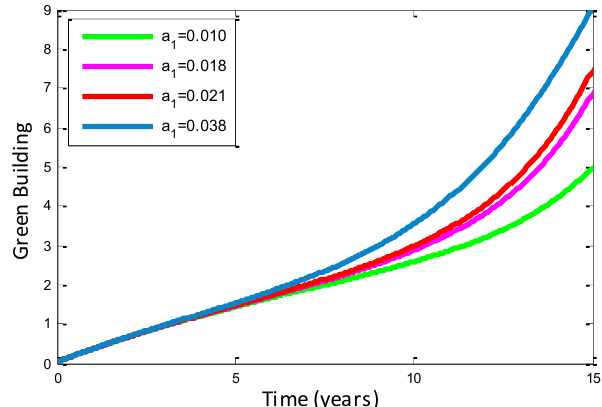
Figure 6 . The growth rate of green building for different values of 1 a